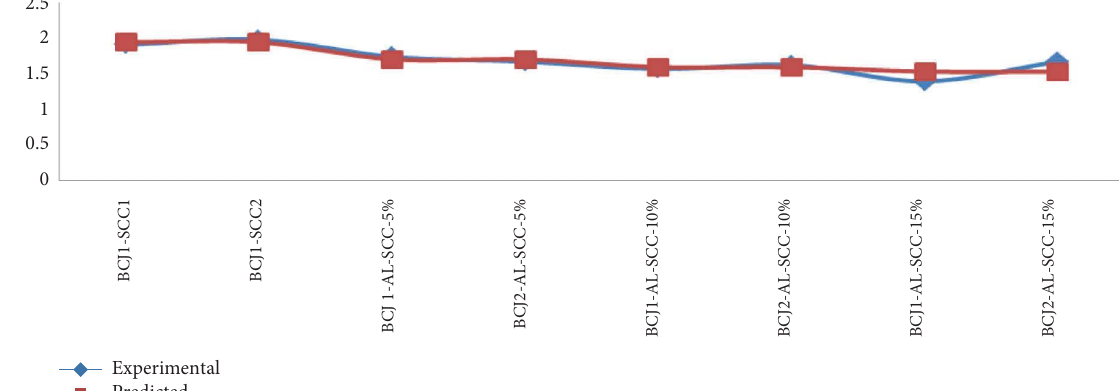
Figure 27: Defection ductility of experimental and predicted